Question: Express in one sentence what the figure is showing.
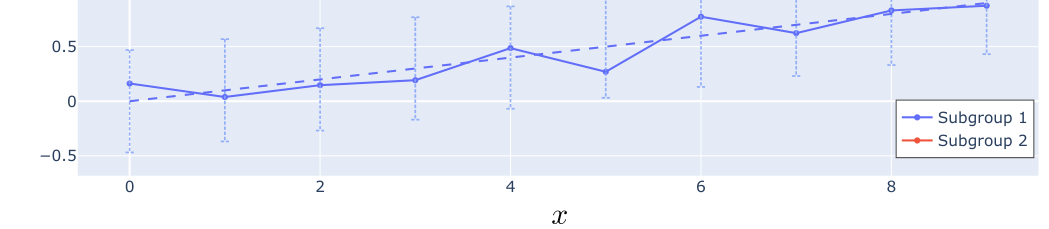
Answer: Two data samples with the same trend but with different noise levels: y(x,s) ∼0.1x + 2s + ε(s), where s ∈{0,1} is a dummy variable labelling the subgroups. The blue subgroup (s = 0) has standard deviation 0.1, while the red subgroup (s = 1) has standard deviation 0.5. Although the prediction intervals are valid at the α = 0.2 significance level, both marginally and for the blue subgroup, this is not the case for the red subgroup.